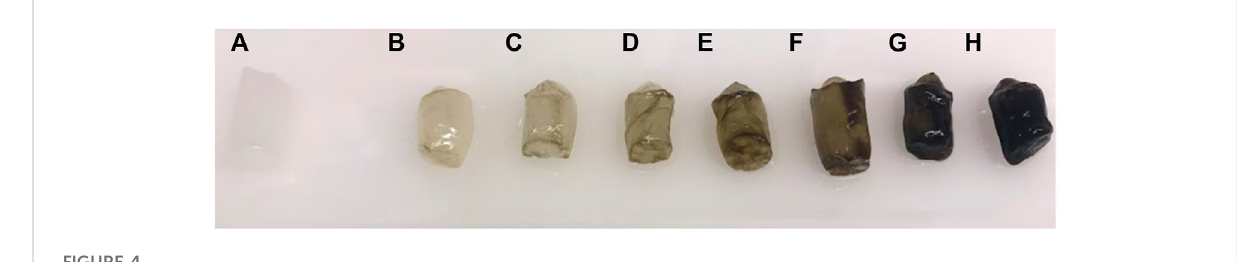
FIGURE 4 DigitalimageofBSA-CGbeforeandafterinteractionwithdifferentconcentrationsofhaeminsolutions: (A) 0; (B) 0.004; (C) 0.008; (D) 0.016; (E) 0.032; (F) 0.065; (G) 0.13 and (H) 0.26 mg/ml haemin in 0.1 M phosphate buffer pH